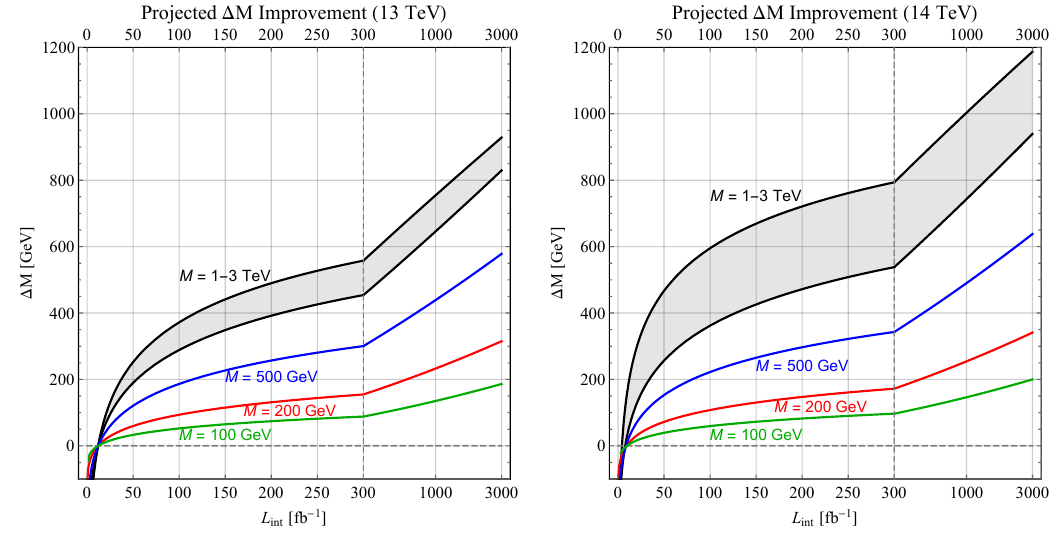
Figure 7 . Projected improvement (cid:1) M to the experimental 95% CL upper limits on a superpartner excluded by 12 fb (cid:0) 1 of 13 TeV data, as a function of integrated 13 TeV (left) or 14 TeV data (right). The black shaded region corresponds to the projected (cid:1) M for an existing limit for a search which currently excludes a particle between 1 and 3 TeV. Here, the improvements are relatively indepen- dent of the limit. The green line is the projected improvement for limit which currently excluded a 100 GeV particle, the red line assumes a 200 GeV present limit, and the blue line assumes 500 GeV. The projection technique is as described in the text and [28]. Note the transition from linear to log scale at 300 fb (cid:0) 1